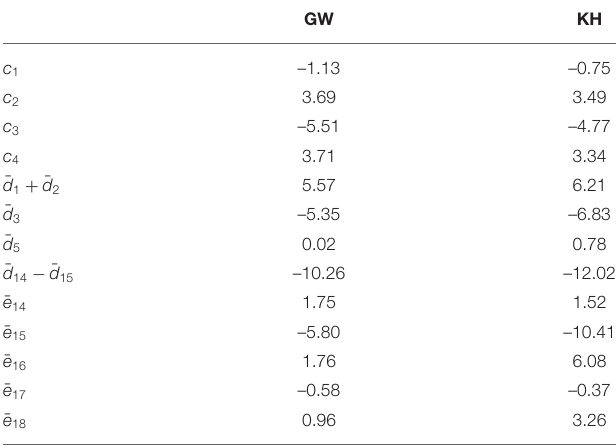
TABLE 2 | Low-energy constants as determined in Krebs et al.